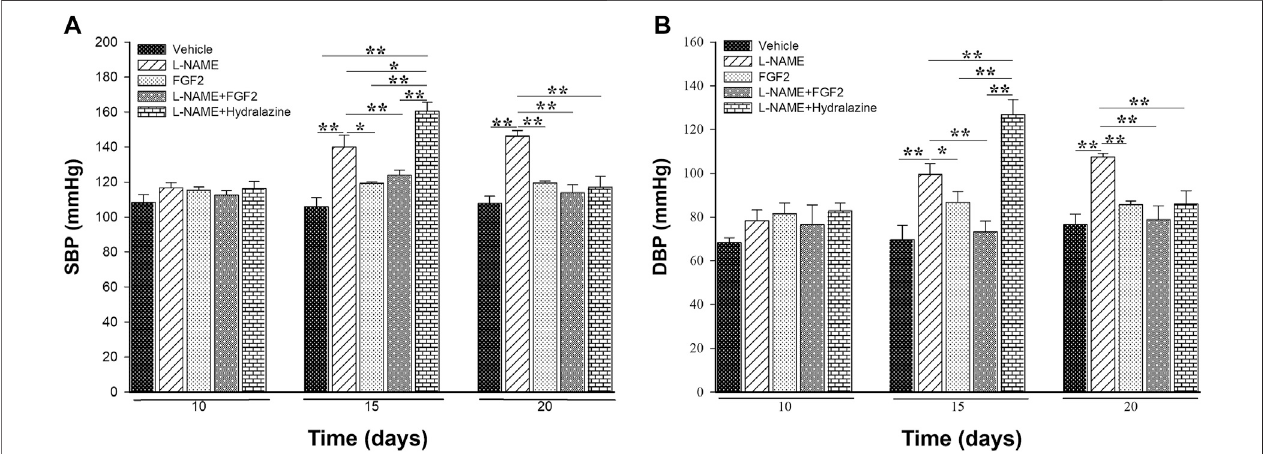
FIGURE 4 | Effect of the administration of 666.6 ng/kg of rhFGF2 on the blood pressure values in pregnant Sprague Dawley rats in the PE-like model induced by L-NAME.Figure showsthemeasurementofsystolicblood pressure (A) anddiastolicbloodpressure (B) amongthestudygroupsthroughout theexperimentalprotocol. Data are expressed as mean ± standard error of seven rats. p -values for the comparison between groups were obtained using one-way analysis of variance (ANOVA) coupled with the Holm-Sidak method. SBP: systolic blood pressure; DBP: diastolic blood pressure. * p < 0.05, ** p < 0.001.